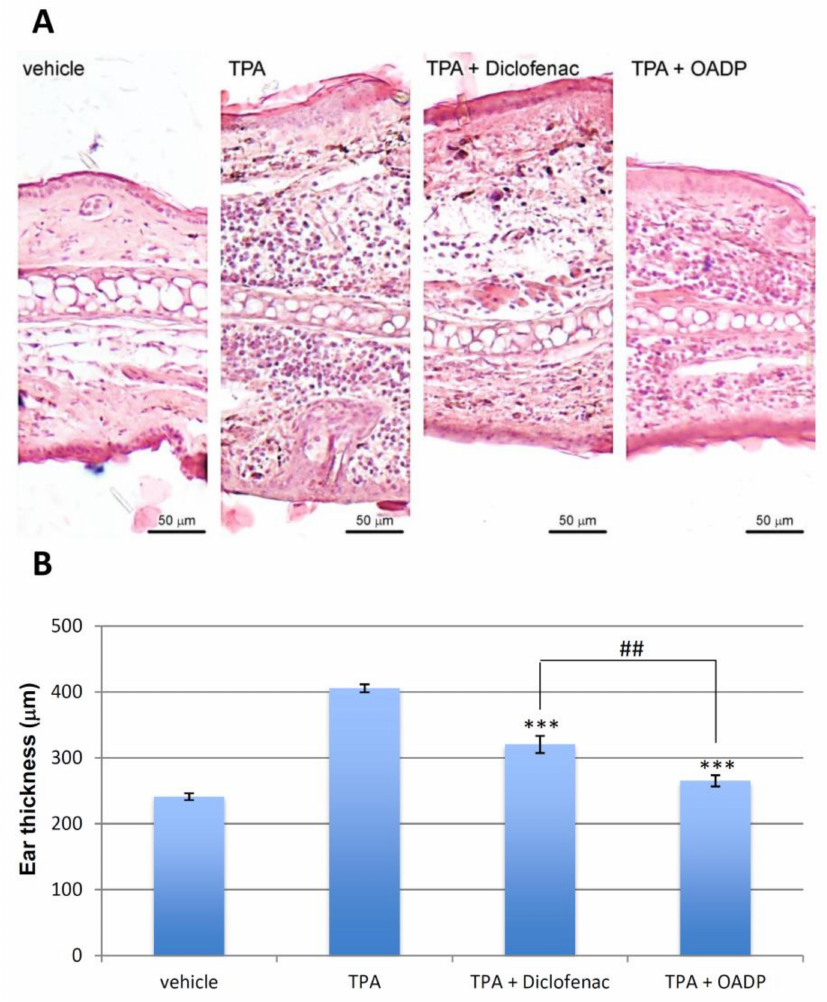
Figure 9. Representative photomicrographs. ( A ) The images show a cross section of the ears treated with vehicle (acetone), TPA alone, TPA + Diclofenac, TPA + OADP, at a 125x magnification. Scale bars = 50 µ m. ( B ) The graph represents the mean thickness of the ear of each treatment, expressed as mean ± S.E.M. (***) p < 0.001 compared to TPA treated ears. ( ## ) p < 0.01 compared to the ears treated with TPA +